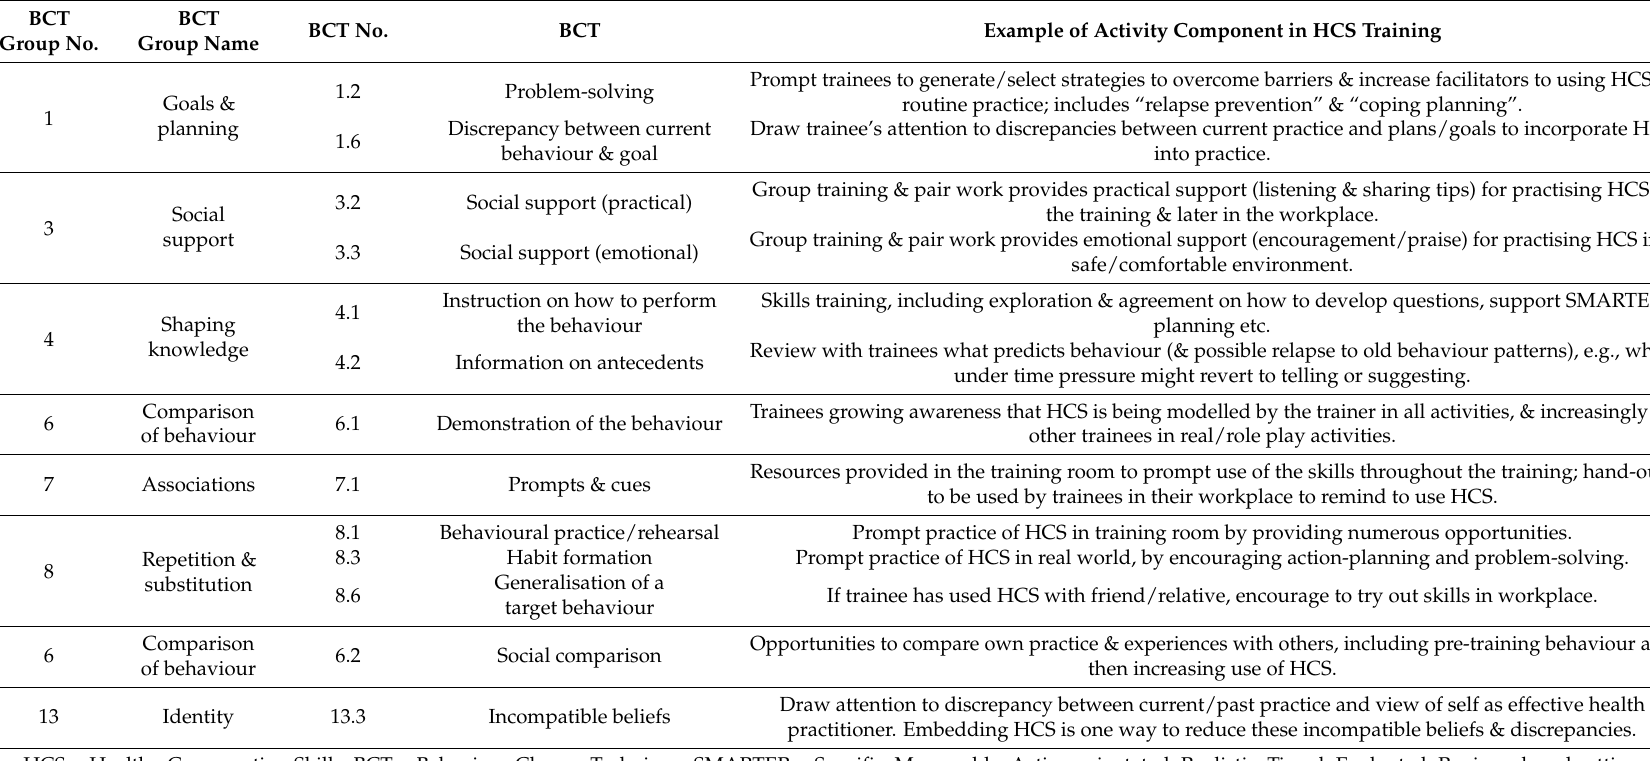
Table 1. Healthy Conversation Skills (HCS) training mapped onto Behaviour Change Techniques (cf. BCT Taxonomy v1: 93 hierarchically-clustered techniques) [26]. BCT Group